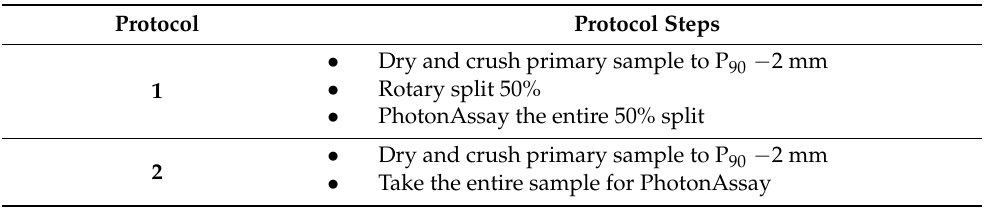
Table 22. Recommended PhotonAssay-based protocols to reduce the FSE and the effects of gold liberation by pulverising (gold loss/contamination).